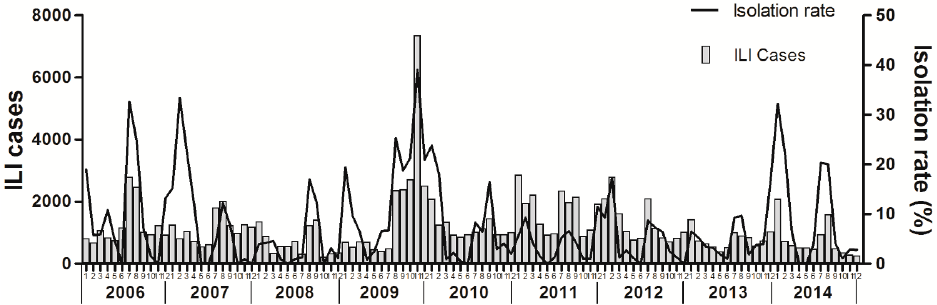
Figure 3. Number of patients with influenza-like illness and positivity rate of influenza viruses isolated by month in Ningbo, China, January 2006 to December 2014.